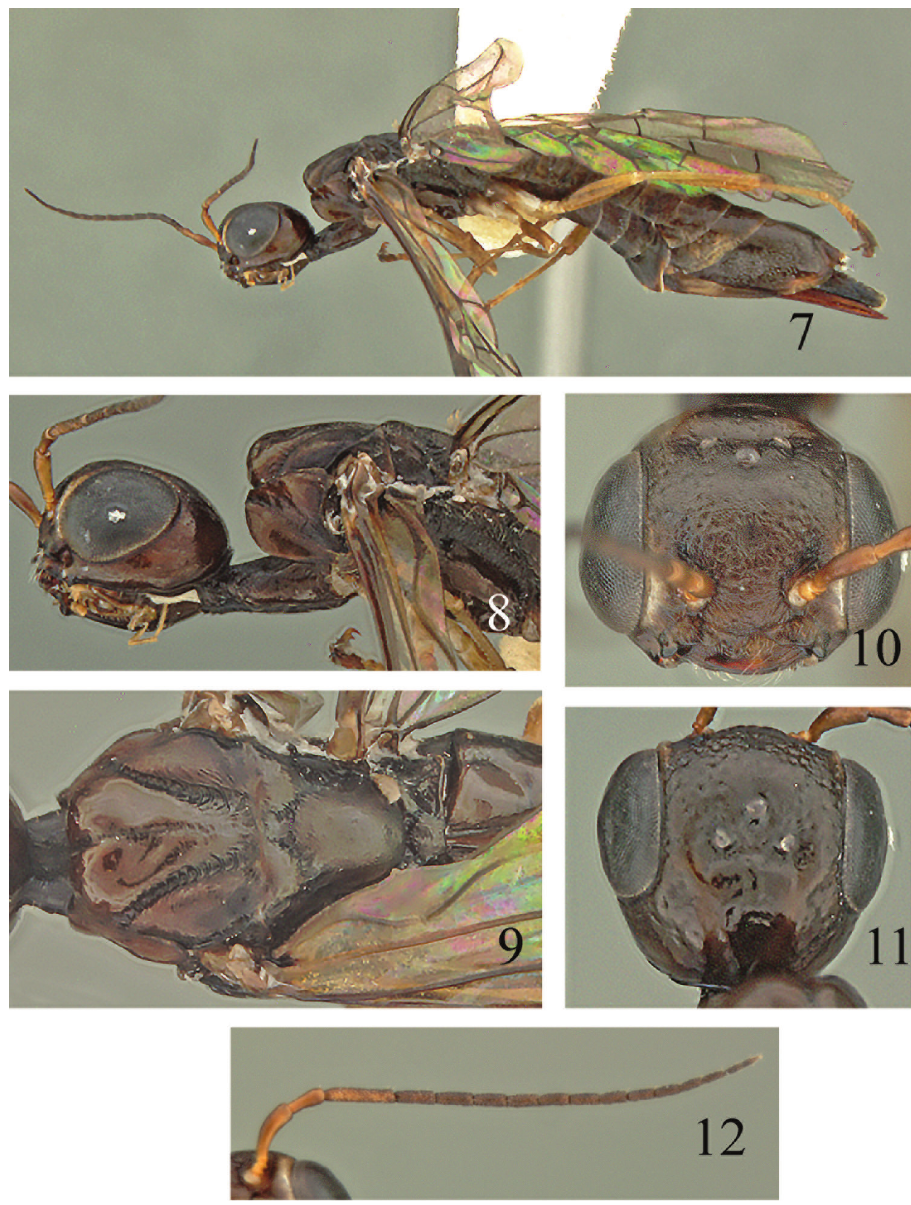
Figures 7–12. Calexiphyda crocea , female. 7 Lateral 8 Head and thorax, lateral 9 Thorax dorsal 10 Head front 11 Head dorsal 12